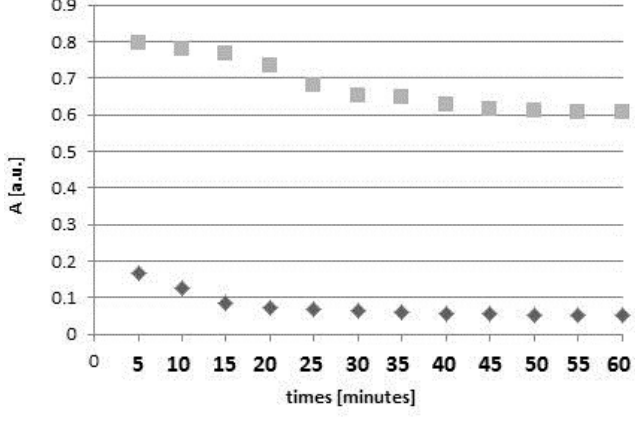
Figure 2. The influence of time (t) of interactions on amplitudes (A) of EPR lines of DPPH in contact with unheated and non-irradiated propolis drops and spray.